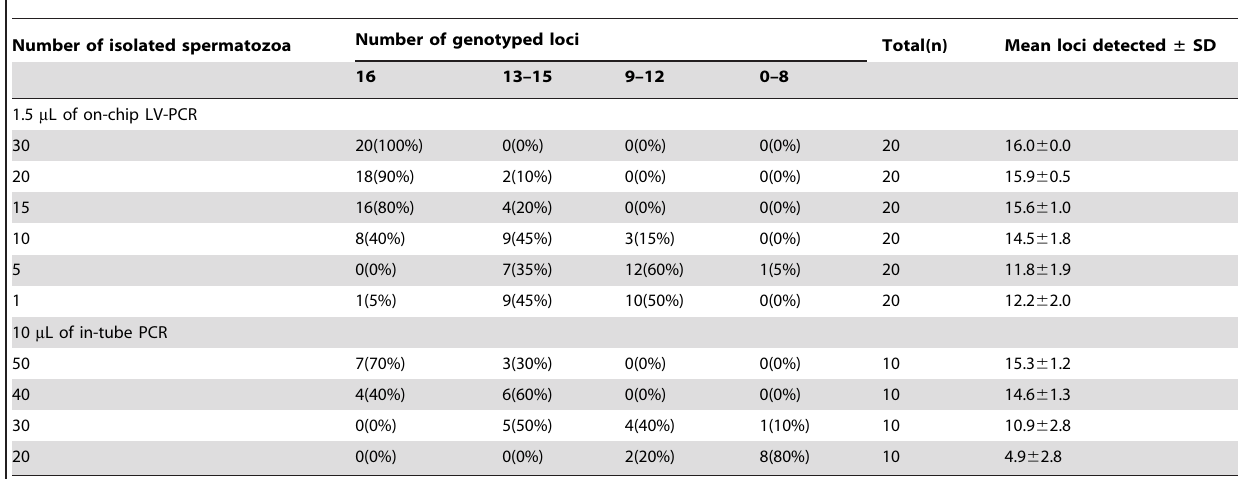
Table 1. Number of genotyped loci following on-chip LV-PCR and in-tube PCR reactions in relation to the amount of spermatozoa analyzed.